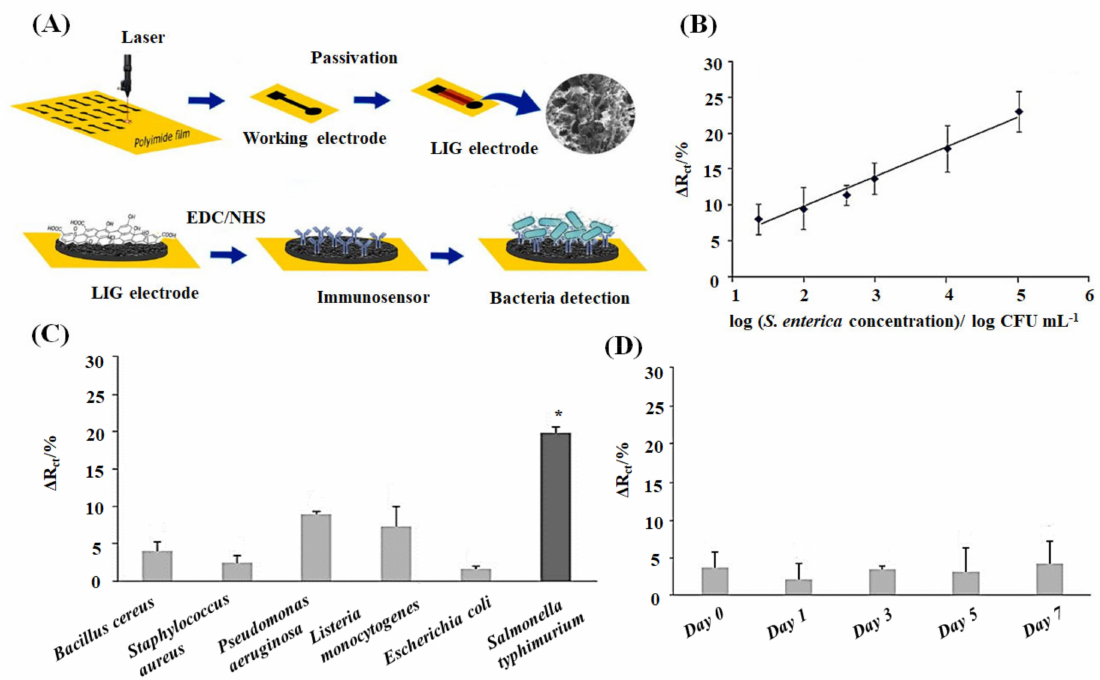
Figure 4. ( A ) Schematic demonstration of fabrication, biofunctionalization, and sensing of the LIG immunosensor. LIG is processed onto a polyimide sheet to create the working electrode, and subsequently, the electrode is passivated with lacquer. SEM image of the LIG surface is shown. The Salmonella antibodies are immobilized on the working electrode via carbodiimide cross-linking chemistry (EDC/NHS) to detect Salmonella microbes. ( B ) The linear calibration curve of charge transfer resistance change ( ∆ R ct ) vs. S. enterica concentrations (generated from Nyquist plots of impedance spectra) in chicken broth. ( C ) ∆ R ct vs. different interferent bacterial species (10 4 CFU mL − 1 ) to show the specificity of the immunosensor. ( D ) Shelf-life test to investigate the stability of the immunosensors for seven days. All the data shown as mean ± SD, n = 3. * means significantly difference ( p < 0.05)